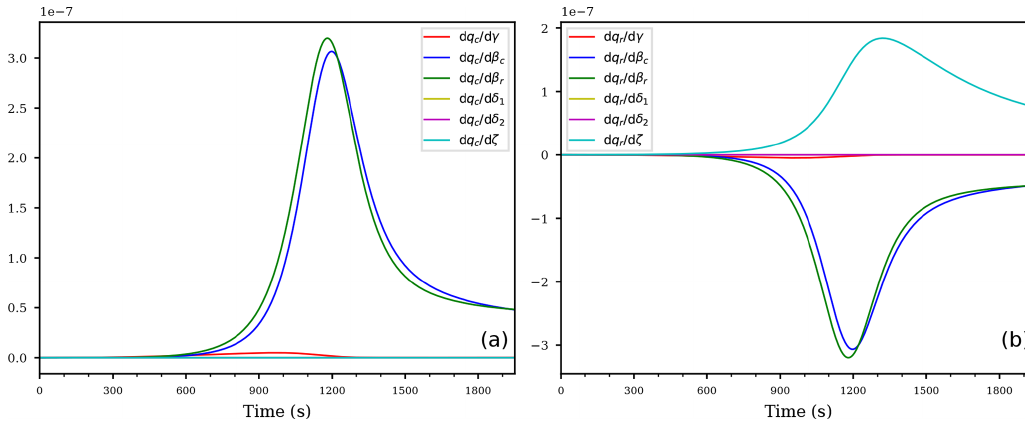
Figure 3. As in Fig. 2, but for the derivatives of q c (a) and q r (b) with respect to the exponents.